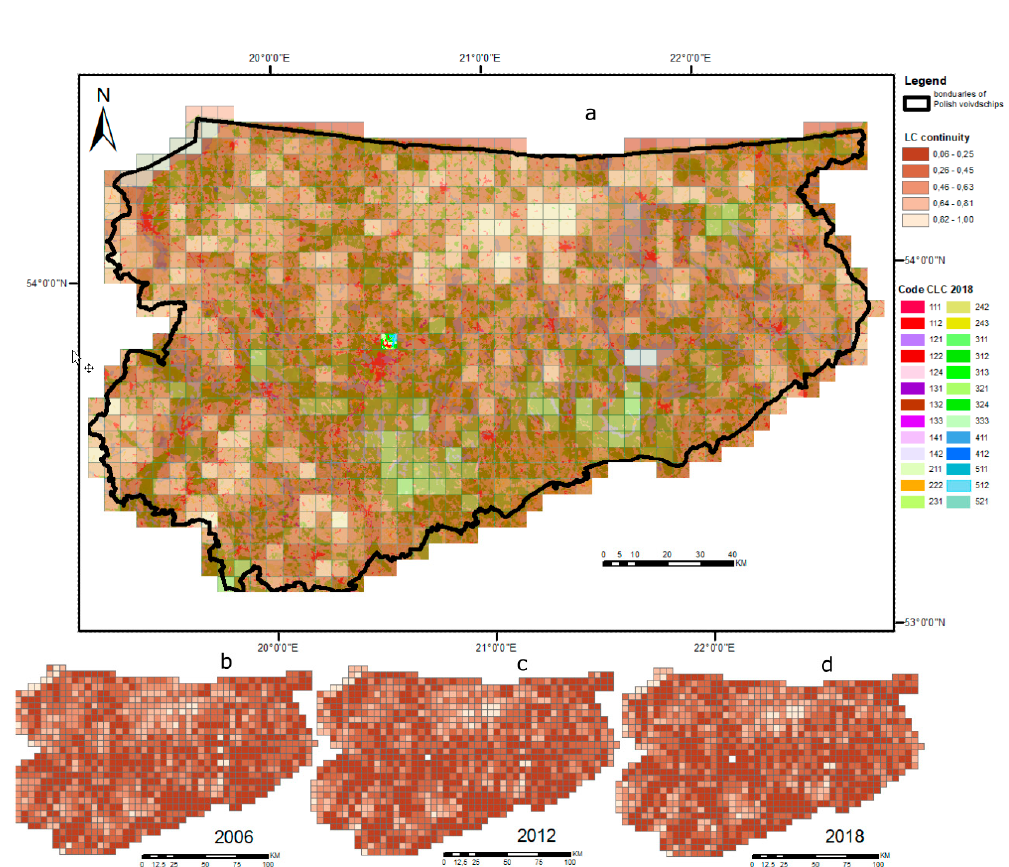
Figure 4. Classification of the LCC indicator. ( a ) classification for 2018 based on CLC data; ( b – d ) classification of the LCC indicator based on data for 2006 ( b ), 2012 ( c ), and 2018 ( d ).